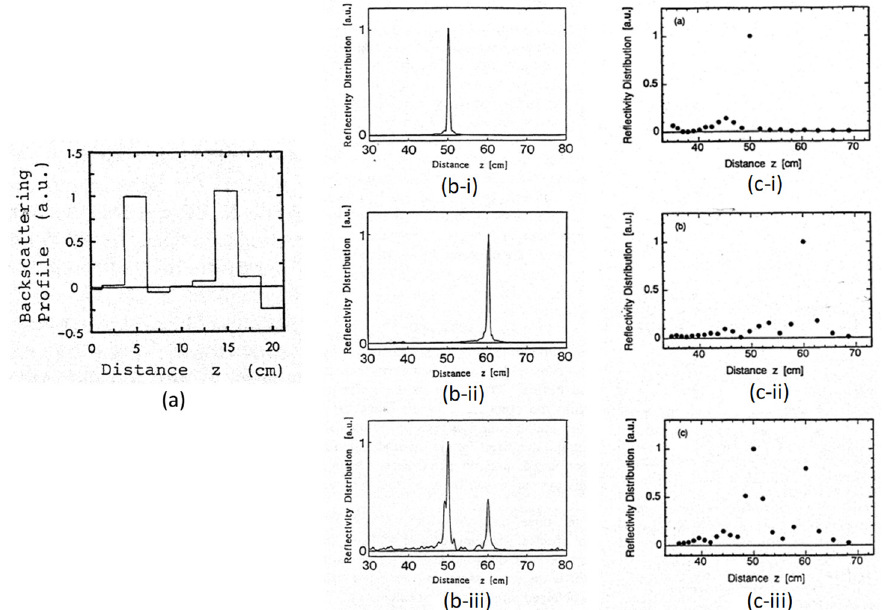
Figure 5. Experimental results obtained by the three kinds of synthesis of optical coherence function (SOCF)-based distributed sensing schemes, as shown in Figure 4 [16]. Results shown in Figure 5a, 5b, and 5c correspond to the three SOCF schemes shown in Figure 4a, 4b, and 4c, respectively.